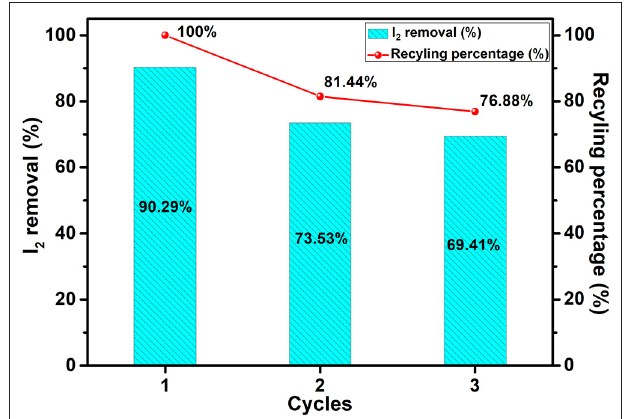
FIGURE 6 | Recycling results of iodine adsorption over JLUE-COP-3.